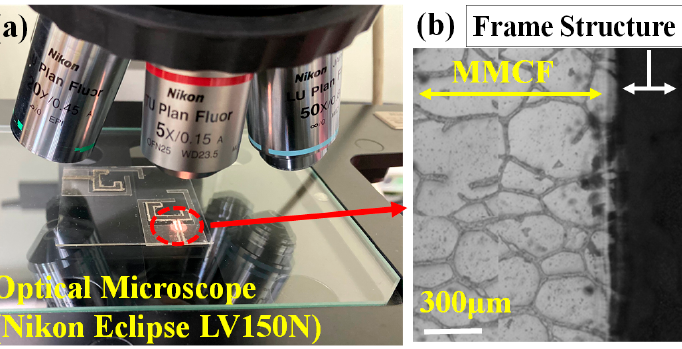
Figure 2. ( a ) Top view and ( b ) 5× objective observation using the NIKON optical microscope platform.